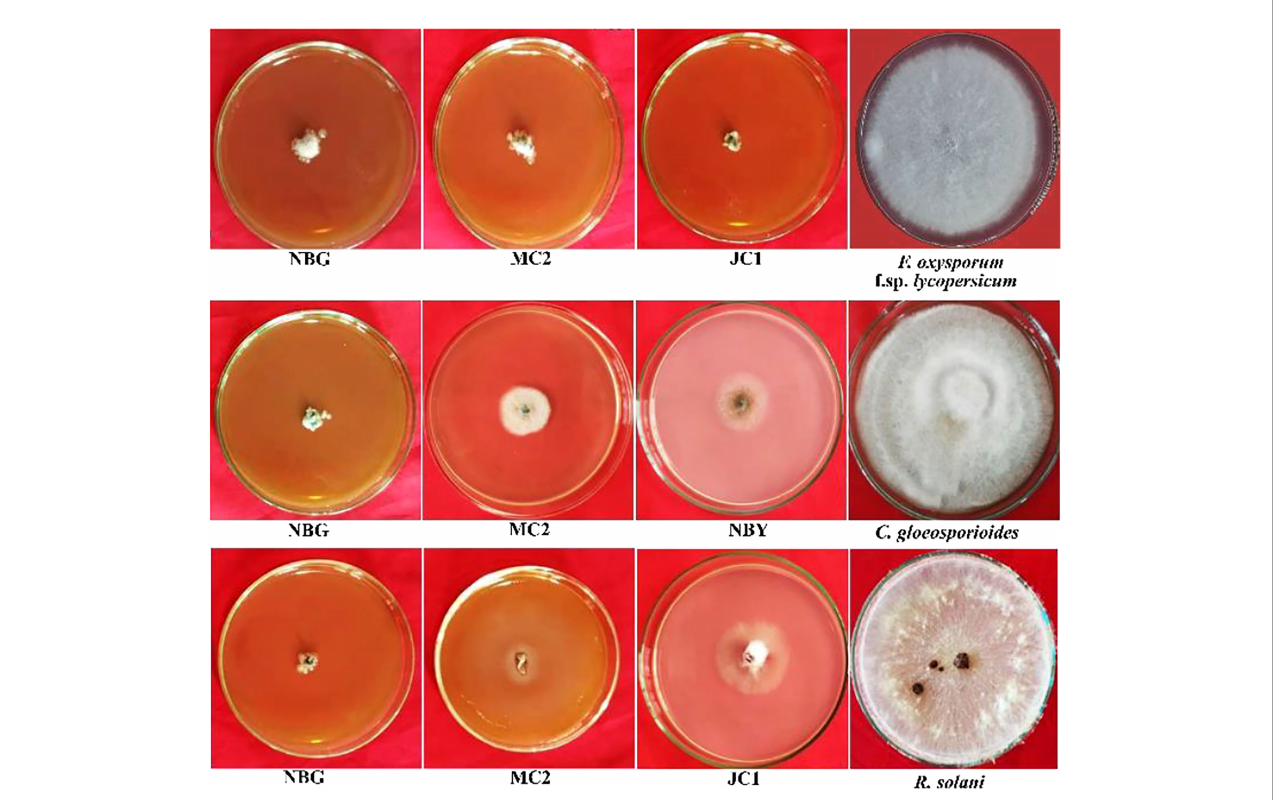
FIGURE 7 Effects of cultural fi ltrates of rhizospheric isolates on the growth of four plant pathogens: Fusarium oxysporum f sp. lycopersicum, Colletotrichum gleoesporioides, Rhizoctonia solani. The highest inhibition of the pathogens was observed at 50% concentration of culture fi ltrate with PDA media for fungal pathogens.